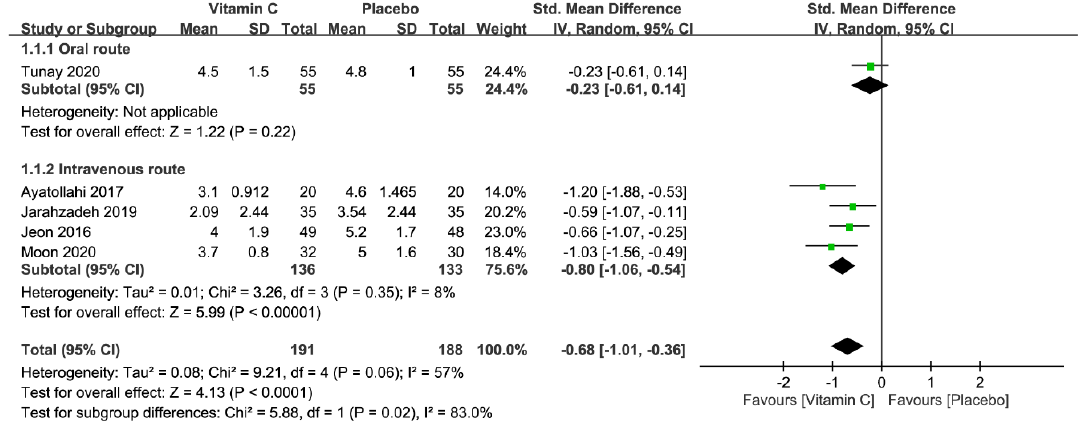
Figure 4. Forest plot for comparing the severity of pain within postoperative 1–2 h between vitamin and placebo groups. CI, confidence interval; IV, inverse variance; Std., standardized.